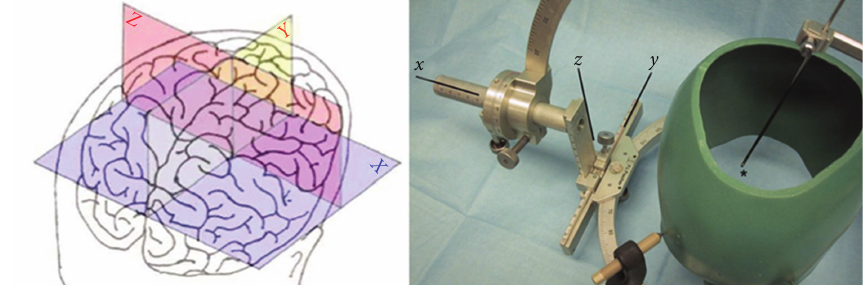
Figure 2: Sketch of a cartesian coordinate system overlaid to a surface sketch of the human brain. Every point within this 3D volume data set is clearly definable by a combination of three coordinates as shown by the skull model fixed to a frame-based sterotaxy system (Zamorano-